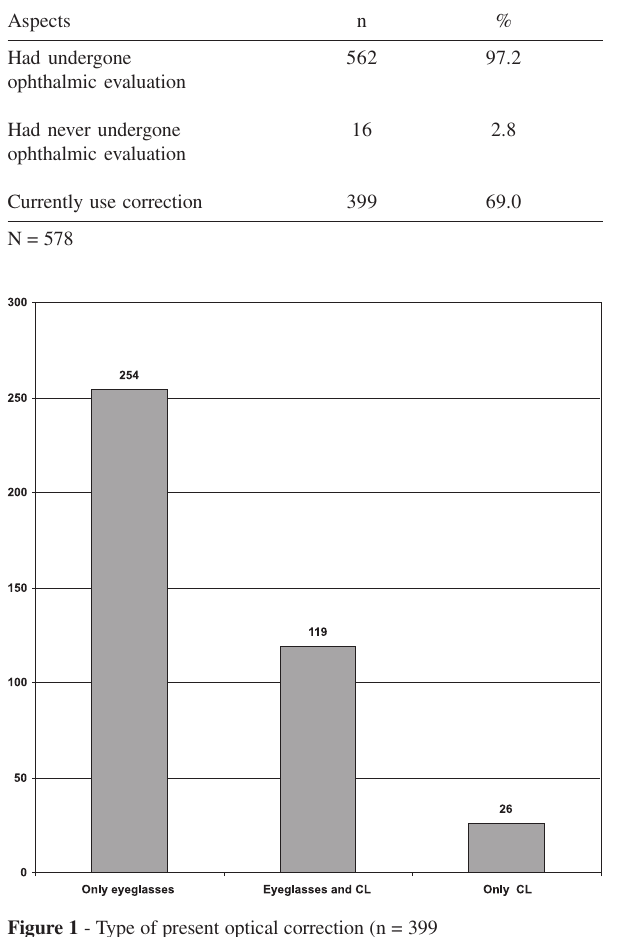
Figure 1 - Type of present optical correction (n = 399 Table 4 - Age range and age at first ophthalmic evaluation among